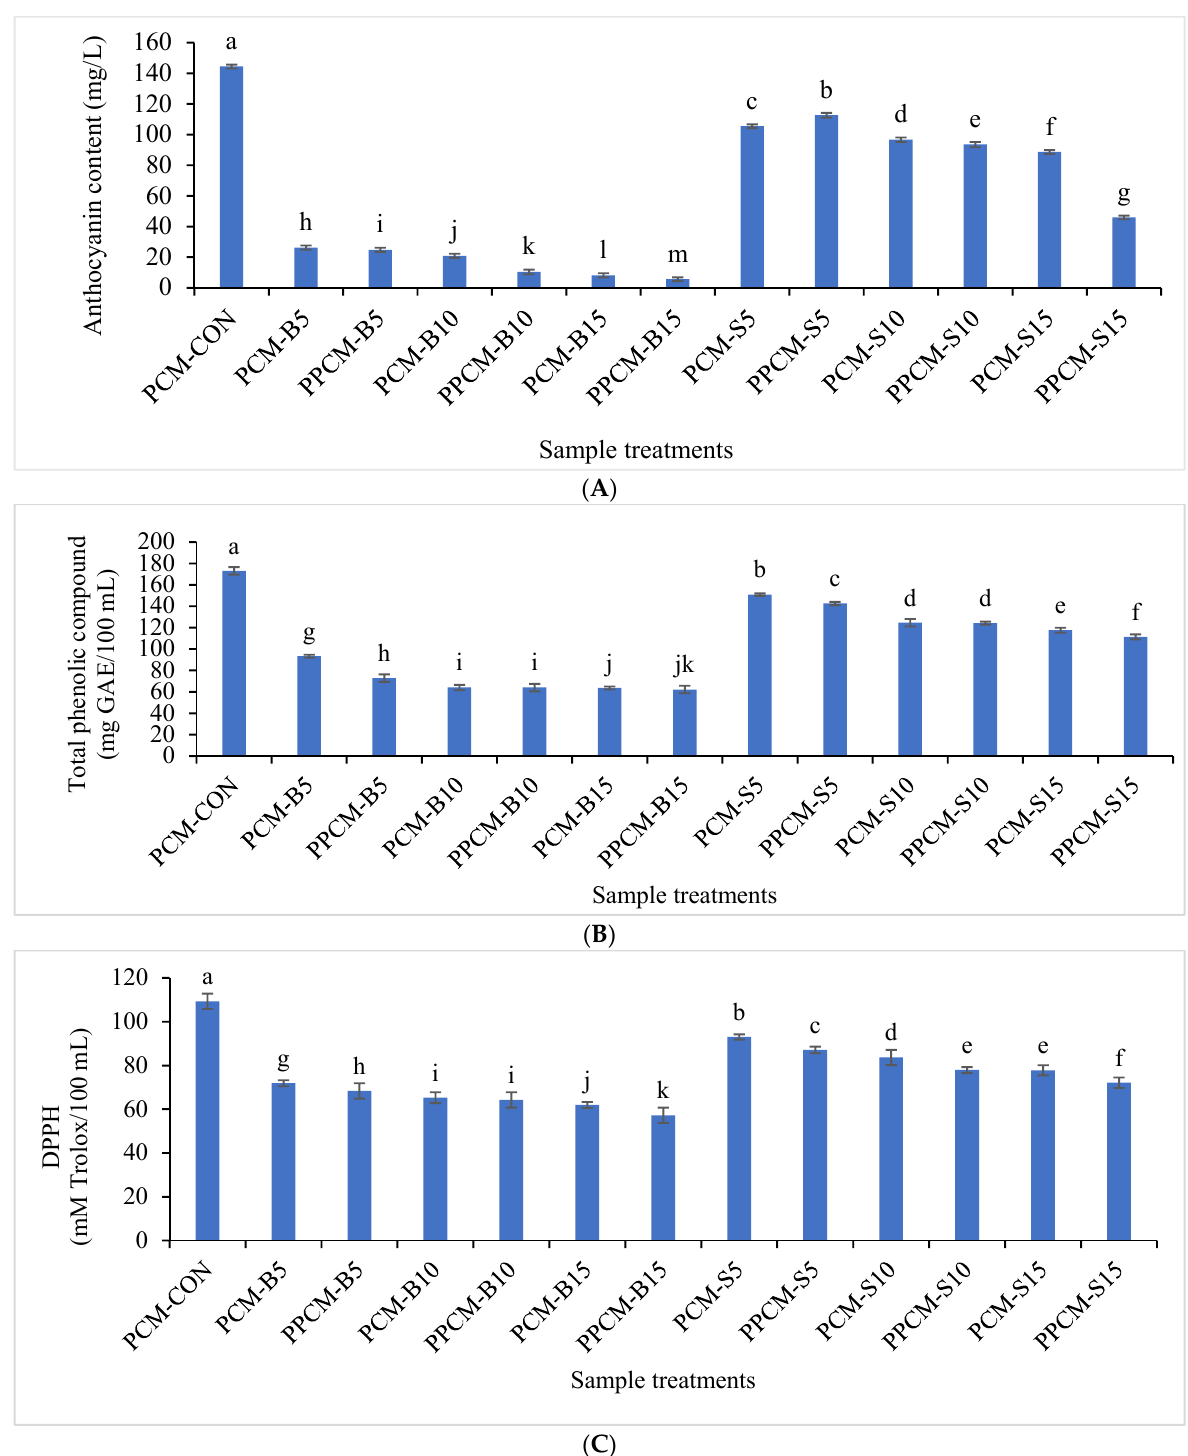
Figure 1. Anthocyanin content ( A ), Total phenolic compound ( B ), and 2,2-diphenylpicrylhydrazyl (DPPH assay) ( C ) of thermally processed PCM. Different lowercase letters on the bars indicate a significant difference ( p ≤ 0.05). PCM: Purple corn milk; PCM-CON: PCM without any treatment; PCM-B5, PCM-B10, PCM-B15, PPCM-B5, PPCM-B10, PPCM-B15: samples extracted from the boiled corn kernels for 5–15 min without and with pasteurization. Similarly, PCM-S5, PCM-S10, PCM-S15, PPCM-S5, PPCM-S10, PCM-S15: samples extracted from the steamed corn kernels for 5–15 min without and with pasteurization.